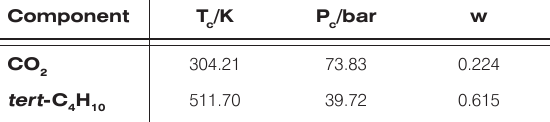
Table 3. Critical data and acentric factor [50] for carbon dioxide and 2-methyl-2-propanol (tert-butanol). Component